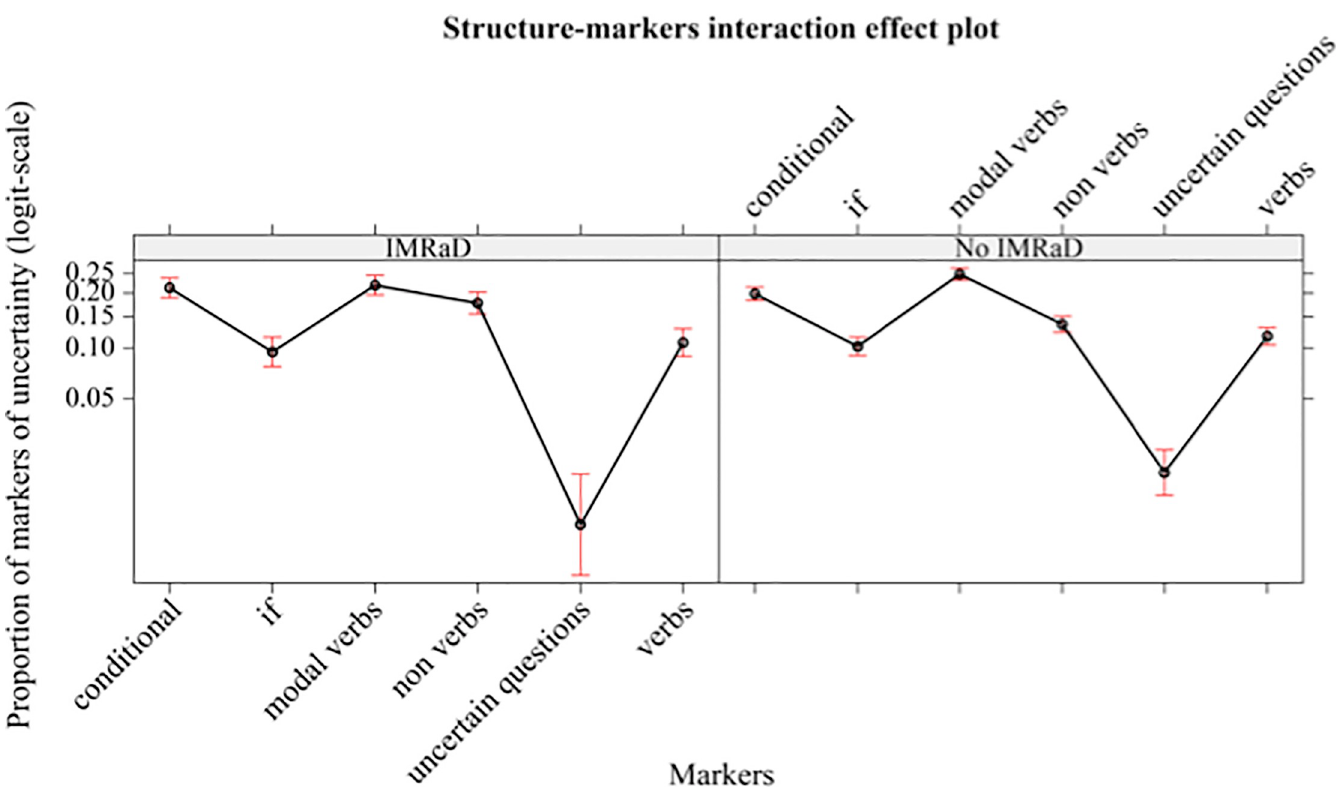
Fig 2. Mean proportions (95% confidence interval) of markers of uncertainty (in logit-scale) of different markers (conditional, if, modal verbs, non-verbs, uncertain questions, verbs), separately by structure (IMRaD, no-IMRaD, BMJ 1840–2007).